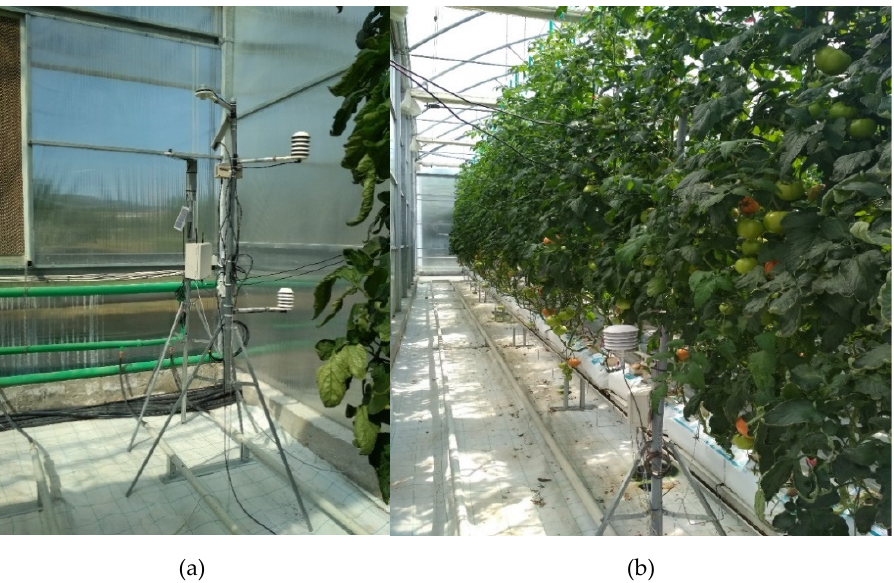
Figure 1. ( a ) The set ‐ up of the multi ‐ sensory tower, ( b ) the tower established within the greenhouse. According to the calibration process, only the PRI sensor values measured during periods with solar radiation values above the crop area higher than 100 W m − 2 were con ‐ sidered. That is why only measurements between 6:30 and 18:30, local time, during each leaves of the treated plants and the mean value was 20 ‐ day period were considered. Values for which the SR was below 100 W m − 2 during the reported period (from 6:30 to 18:30, local time) were also removed.